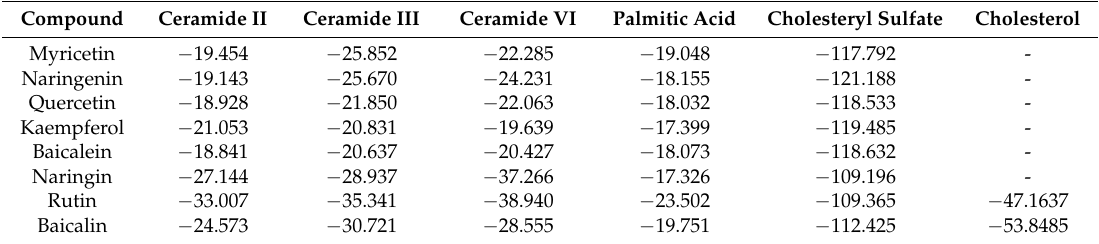
Table 4. The negative CDOCKER energy of aglycone and glycoside flavonoids to interact with the stratum corneum components determined by molecular modeling.